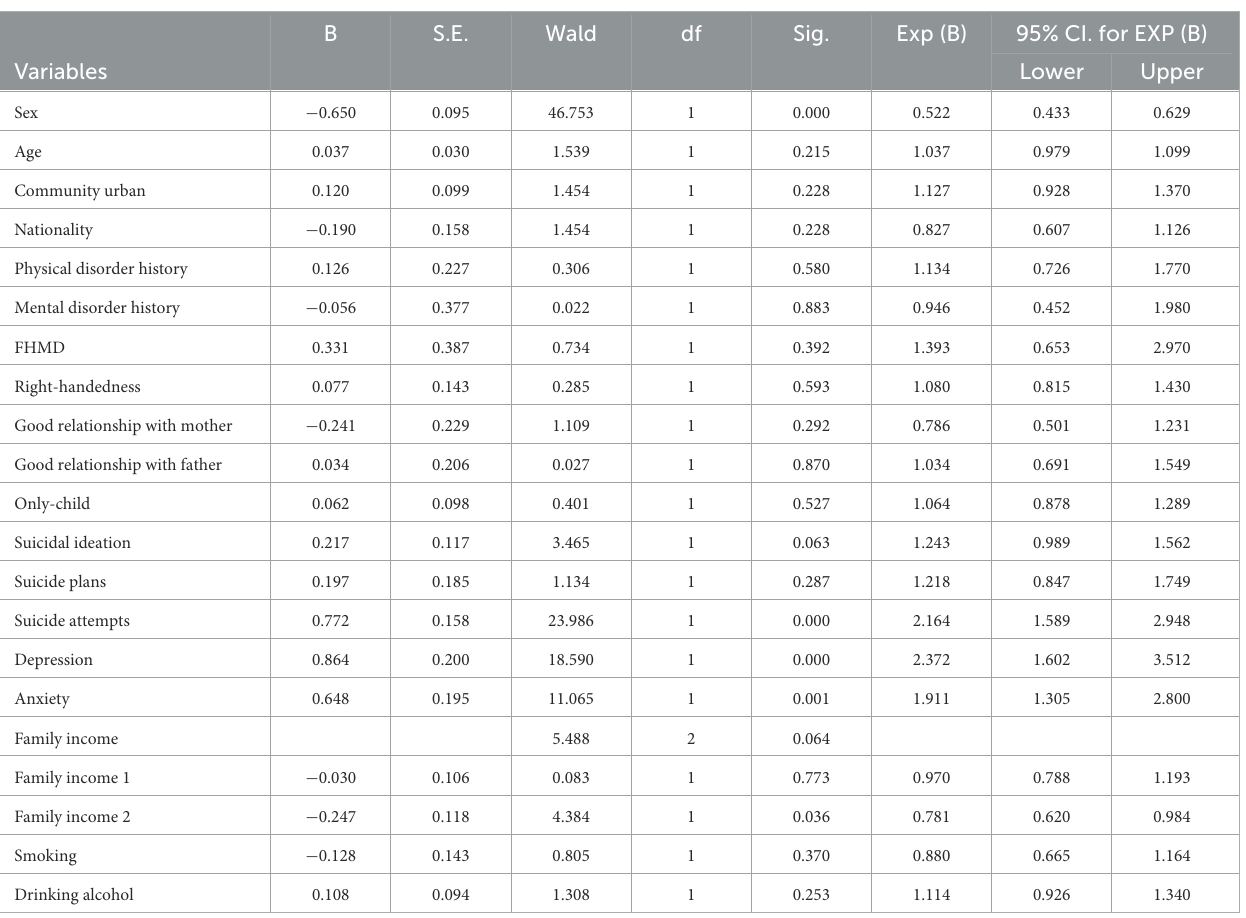
TABLE 2 Binary logistic regression analysis for variables associated with